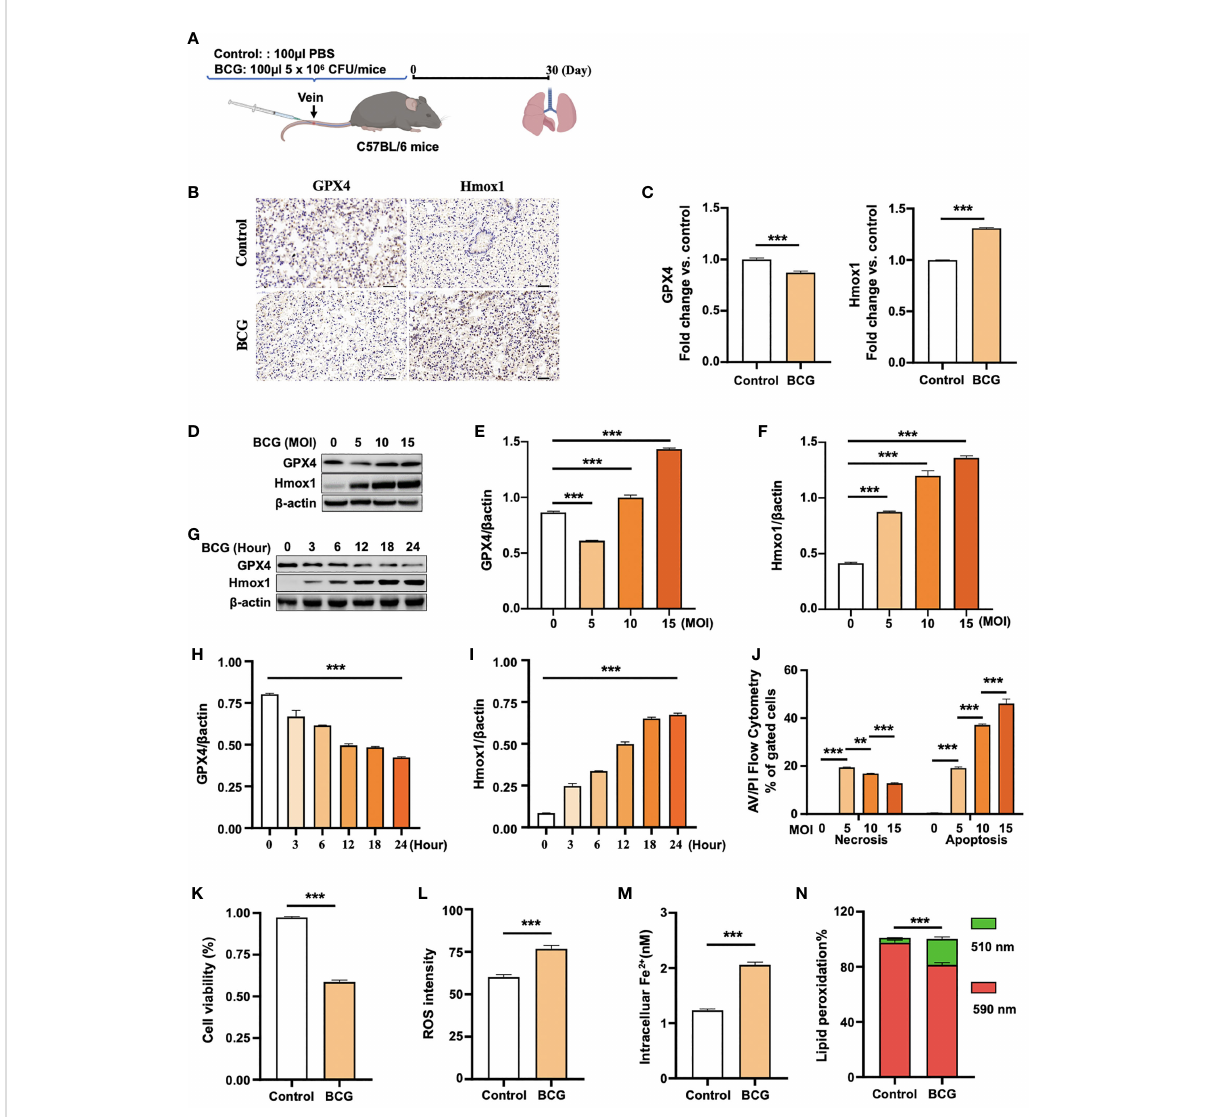
FIGURE 2 BCG induces ferroptosis in macrophages. (A) Schematic diagram shows the infection of mice with BCG via tail vein injection. The infected mice are analyzed at 30 days post-infection (DPI). (B, C) C57BL/6 mice were injected with 5 × 10 6 CFU BCG in 100 µl via the tail vein and the lungs were harvested for evaluating the expression of Gpx4 and HO-1 proteins at 30 DPI by immunohistochemical (IHC) assay (B) and semi-quanti fi ed by ImageJ-IHC Pro fi ler (C) . Lungs of mice infected with BCG showed less and more abundant Gpx4 and HO-1 proteins compared to the uninfected controls, respectively. Bar represents 500 m m in (B) (D-F) RAW264.7 murine macrophage-like cells were infected with BCG at indicated MOI for 24 h, and the abundance of Gpx4 and HO-1 proteins was examined by Western blotting assay. The representative blots (D) and semi-quanti fi cation of Gpx4 (E) and HO-1 (F) showed a dose-dependent induction of Gpx4 and HO-1 in this type of cells, except an inhibition of Gpx4 expression in cells infected with a low dose of BCG at an MOI of 5. (G – I) The representative blots (D) and semi-quanti fi cation of Gpx4 (H) and HO-1 (I) demonstrated a time-dependent inhibition of Gpx4 and induction of HO-1 in RAW264.7 infected with BCG at an MOI of 5 for a 24-h time period. (J) Induction of cell necrosis and apoptosis in RAW264.7 cells at 24 h post-infection of BCG at the indicated MOI determined by using Annexin V/PI in fl ow cytometry. (K) Cell viability assay showed that the infection of BCG decreased the viability of RAW264.7 cells at an MOI of 5 for 24 has detected by Trypan Blue assay. (L) The infection of BCG induced the production of intracellular ROS in RAW264.7 cells at an MOI of 5 for 24 has detected by fl ow cytometry assay. (M) The infection of BCG increased the concentration of intracellular Fe 2+ in RAW264.7 cells at an MOI of 5 for 24 has detected using iron ion probes. (N) The infection of BCG induced lipid peroxidation in RAW264.7 cells at an MOI of 5 for 24 h as determined by BODIPY 581/591 C11 assays. Upon oxidation, its excitation of Red/590 nm shifts to 510 nm (Green). The ratio of Green/Red cells in the BCG-infected cells was 17.22%, while the uninfected cells was 3.52%. Data obtained from three independent experiments were processed using GraphPad Prism 8.0.1 software and ImageJ 1.52.a. Unpaired t -test was used to analyze the differential changes of the two groups. One-way ANOVA and Tukey ’ s multiple comparisons test was used to analyze the differential changes of multiple groups. Data represented mean ± SD from three independent experiments; signi fi cant differences are indicated with asterisks (** p < 0.01; *** p <